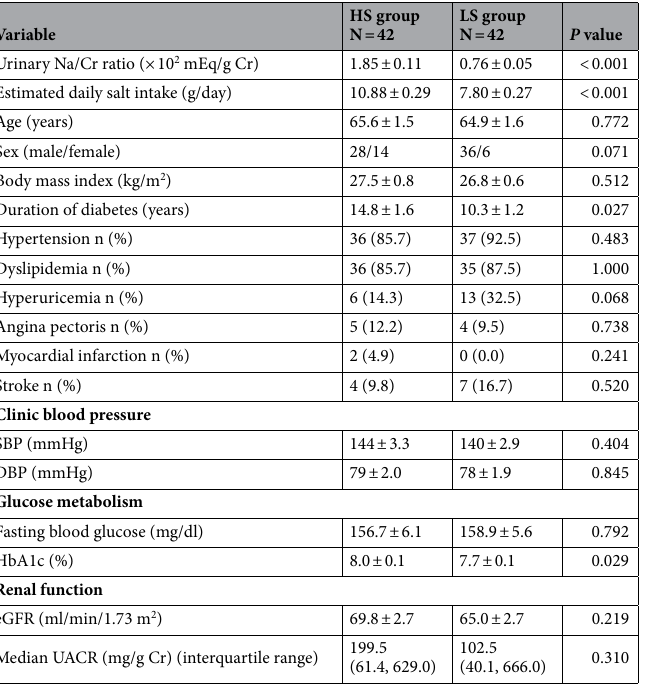
Table 1. Baseline characteristics of the participants. Values are mean ± standard error (SE). UACR is expressed as median (interquartile range). Analyses were performed using unpaired t -tests for continuous data and Fisher’s exact tests for categorical data. Mann–Whitney U test was used for analysis of UACR. HS group high sodium intake group, LS group low sodium intake group, Na sodium, Cr creatinine, SBP systolic blood pressure, DBP diastolic blood pressure, HbA1c glycated hemoglobin, eGFR estimated glomerular filtration rate, UACR urine albumin-to-creatinine